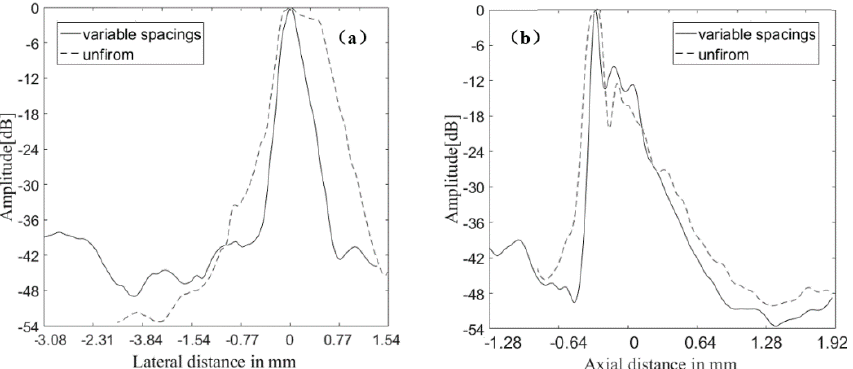
Figure 17. Lateral and axial envelope of echo signals of the point a acquired by ( a ) the MULA and ( b ) the MNULA.